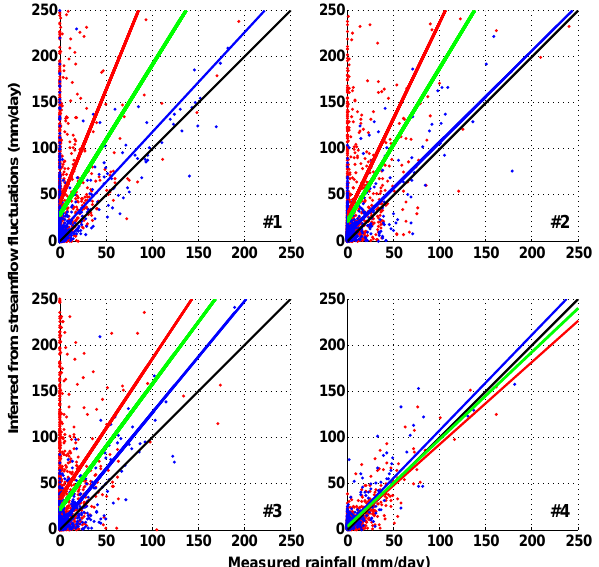
Measured rainfall (mm/day) Figure 7. Inferred versus measured daily precipitation for the study catchments: #1. Ardèche at Meyras; #2. Borne at Nicolaud Bridge; #3. Thines at Gournier Bridge; #4. Altier at Goulette. Blue dots correspond to the inferred daily totals from low-vegetation pe- riods; red points correspond to the inferred daily totals from vegeta- tion periods; blue line is correlation for low-vegetation periods, red line for vegetation periods and green line for total examined